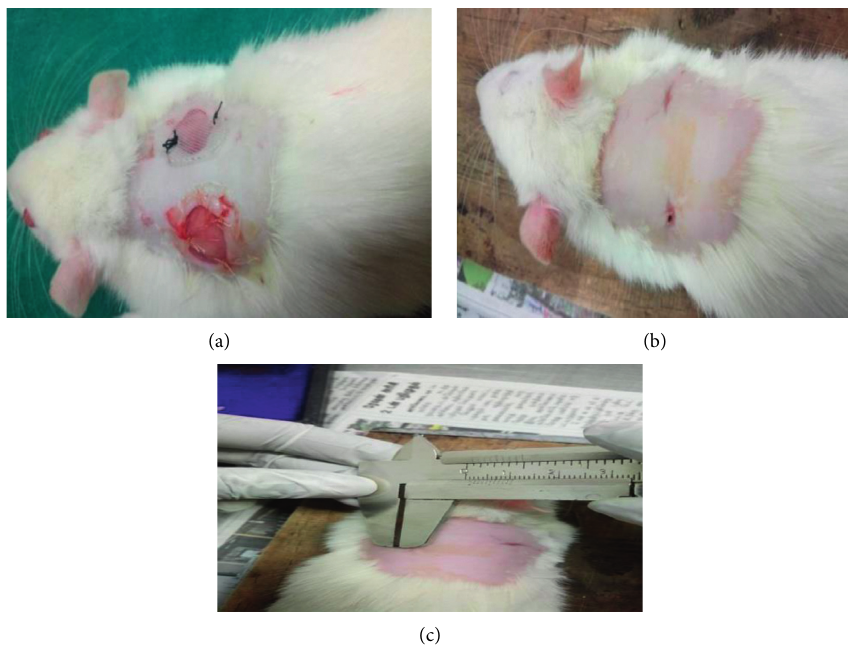
Figure 10: Group II animals tested with a combination of dHAM, TSP gel, and immature coconut fiber compared with silk suture and silicone gel membrane (positive control). (a) dHAM+TSP gel +coconut fiber (Left side) and silicone gel membrane +silk suture (right side). (b) After 11 days, the test sample on the left side showed healing in comparison with completely healed positive control on the right side. (c) Wound site measurement (1.5mm) at the test site (dHAM+TSP gel+coconut fiber) after 11 days. The silicone gel membrane+ silk suture site (positive control) was completely healed after 11 days, and hence no measurement was taken. Values are expressed as mean ± SE ( n � 3), where p ≤ 0 . 05).